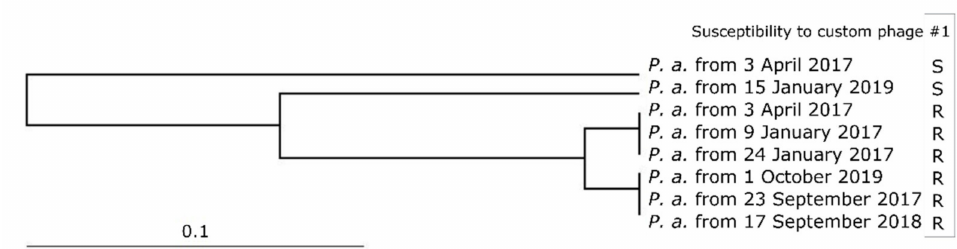
Figure 2. Clustering of Pseudomonas aeruginosa strains of patient #1. Susceptibility to the custom phage is shown across the isolation date of each strain. Cluster 1: P. a. from 3 April 2017b, P. a. from 9 January 2017, P. a. from 24 January 2017. Cluster 2: P. a. from 1 October 2019, P. a. from 23 September 2017, P. a. from 17 September